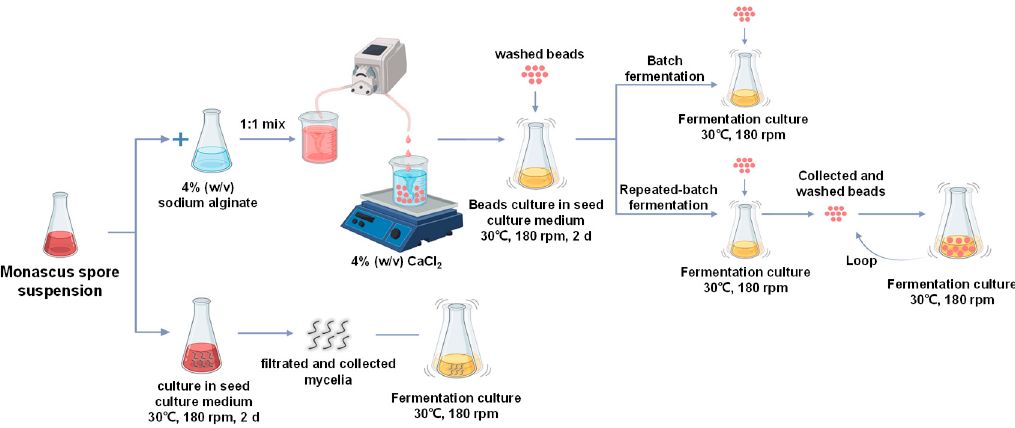
Figure 1. Procedures of free-cell fermentation and immobilized-cell